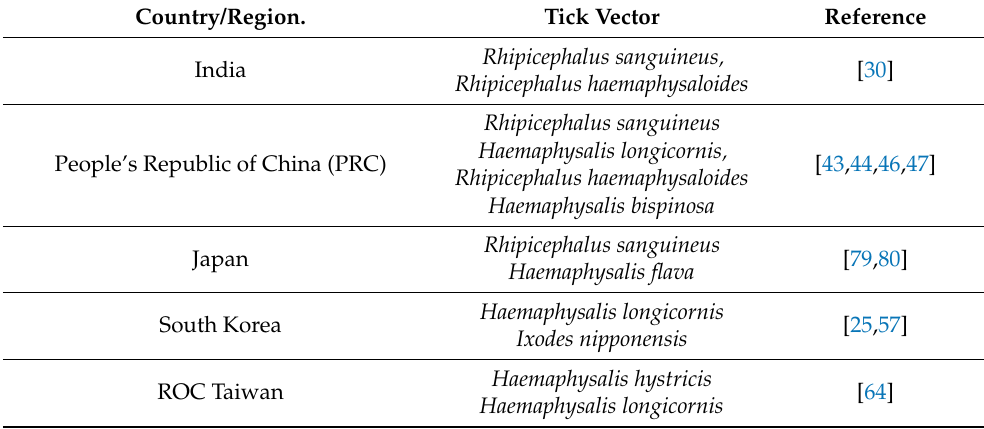
Table 2. Reported tick species carrying ehrlichiosis in south and east Asian countries/regions.